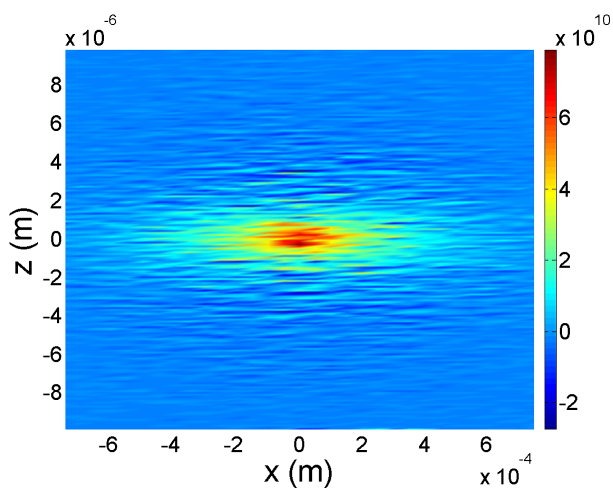
FIG. 8. 2D (x and z) plot of density modulation, measured in numbers of electrons per square meters, by stationary ( v 0 ;z ¼ 0 ) ion in the center of the Gaussian electron